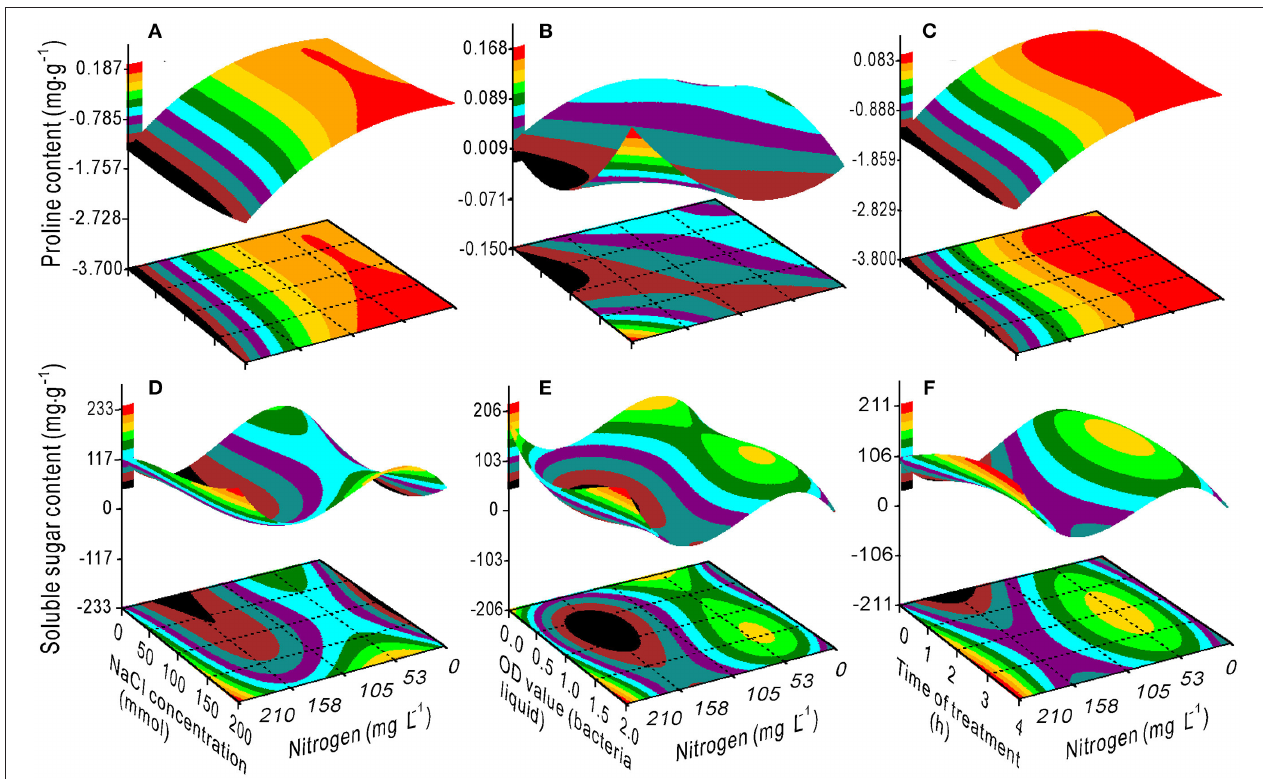
FIGURE 6 | Response surface plots showing the interactions between NaCl, bacterial liquid, and treatment time with nitrogen on the proline (A–C) and soluble sugar (D–F) contents.